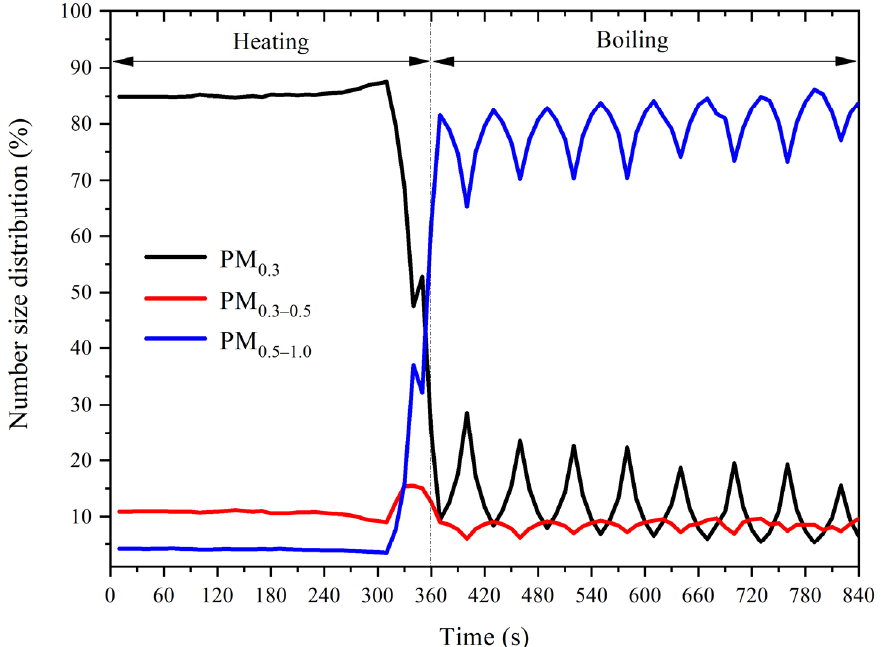
Figure 4. Variation in particle size distribution during water boiling.